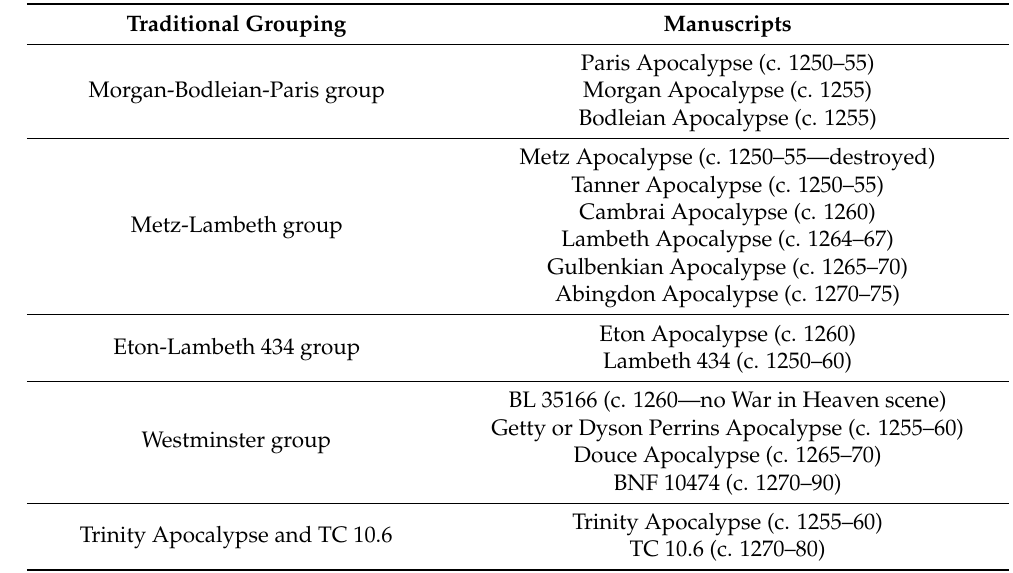
Table 1. Common chronological and stylistic grouping of Anglo-Norman illustrated Apocalypse